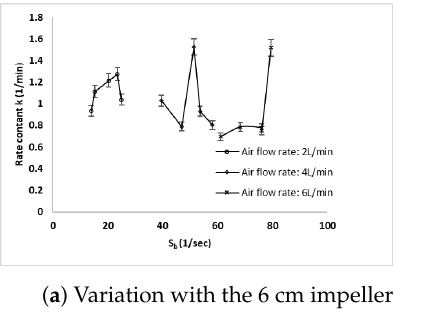
Figure 15. Copper flotation rate constant vs. bubble surface area flux with different diameter impellers where ( a ) shows variation with 6 cm impeller and ( b ) shows variation with 7 cm impeller.